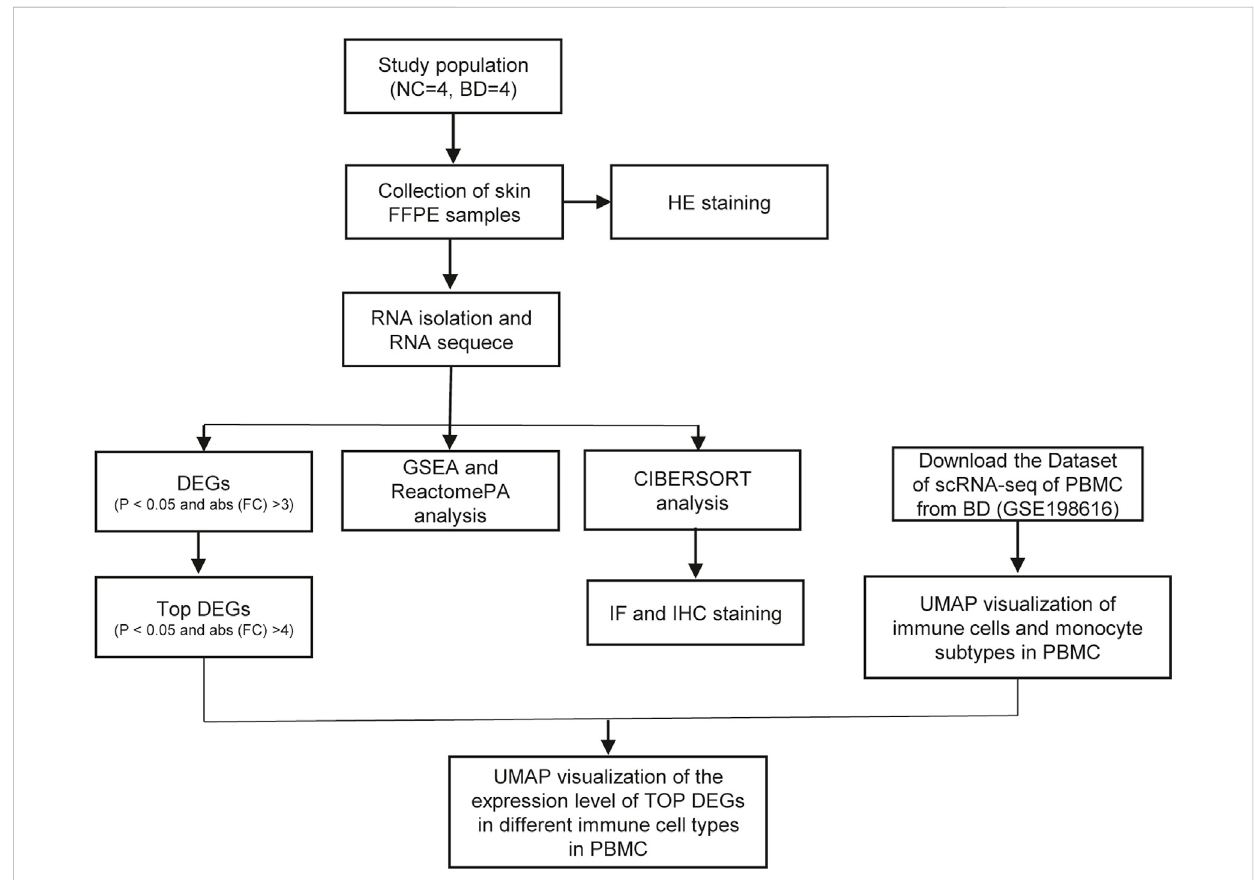
The fl ow chart of study design. In this study, 4 BD patients and 4 NCs were enrolled in this study. RNA-seq of the skin of BD patients and NCs were conducted. The DEGs between BD and NCs were analyzed, and functional analysis of these DEGs were conducted. Using the deconvolution method CIBERSORT, we analyzed the immune cells subtypes in skin of BD by integrating the scRNA-seq of PBMC and bulk RNA-seq data of skin. Among these immune cell types, monocyte, ISG15 + Mono and C1q + Mono were con fi rmed by IHC and IF staining respectively. UMAP visualized of the expression levels of top DEGs in different immune cell types in